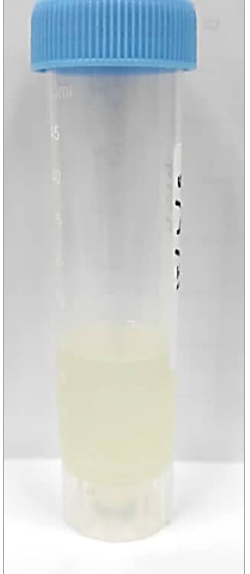
Figure 1. Nanoemulsion produced using ultrasonication method (NE-FLO).